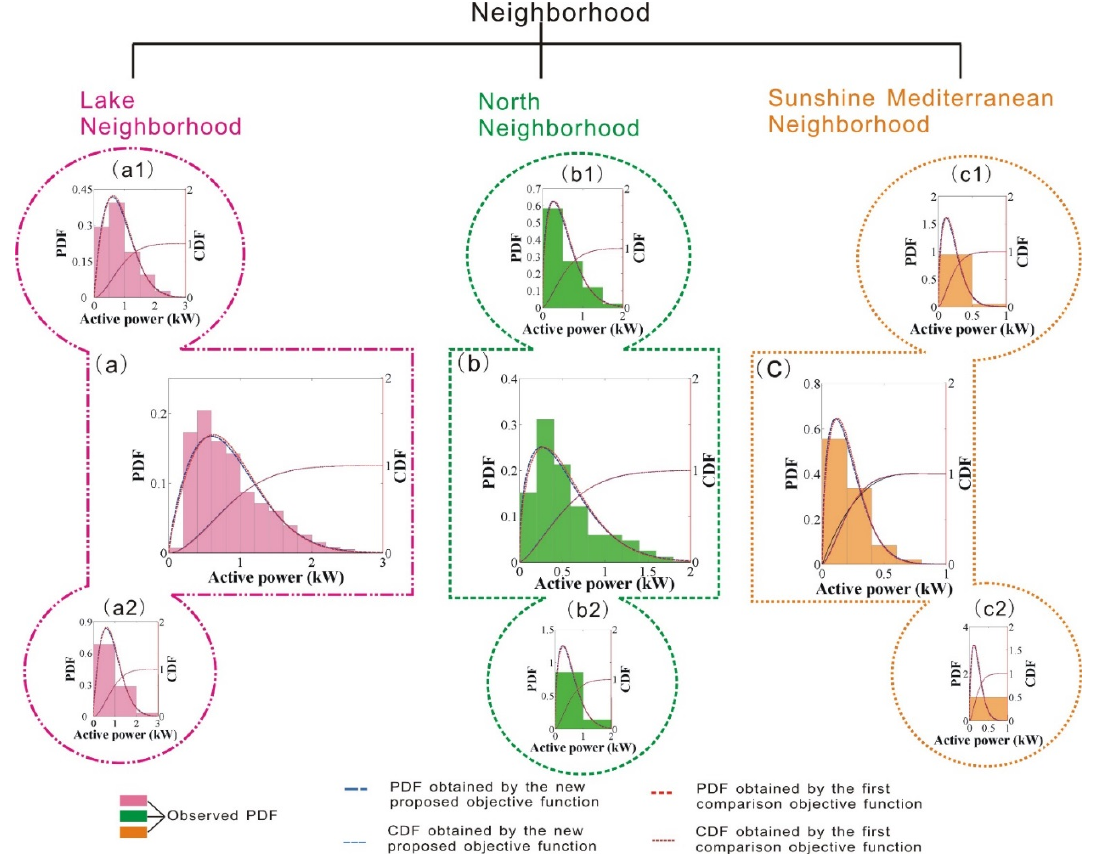
Figure 3. PDF and CDF results of the active power in the three neighborhoods by dividing the unit interval into different subintervals.